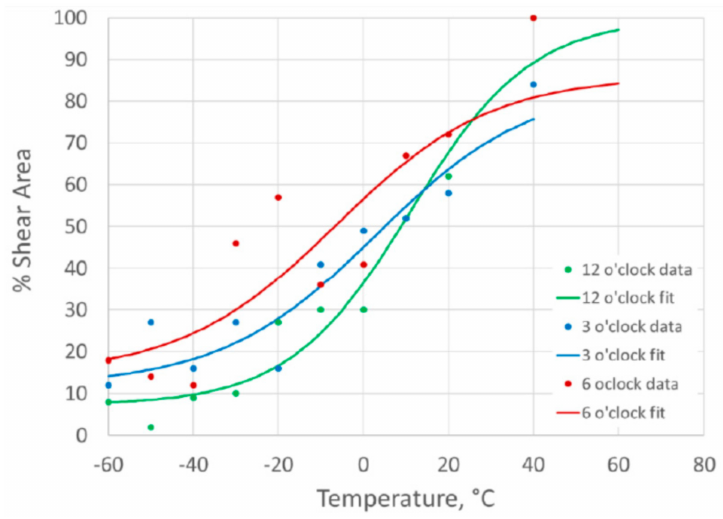
Figure 9. Charpy impact energy ductile-to-brittle transition curves for HAZ notched specimens.